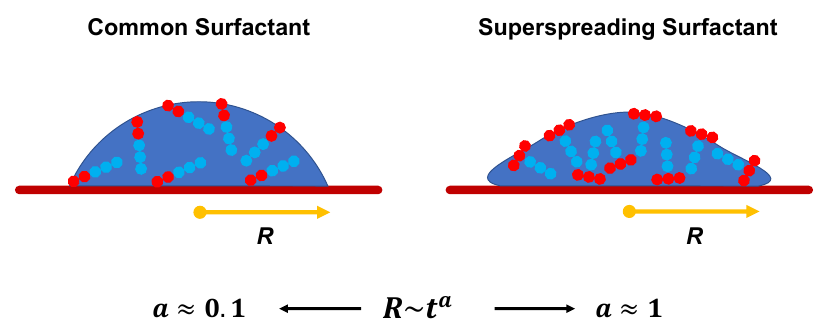
Figure 1. Schematics of aqueous droplets on a solid substrate at an intermediate time during spreading. Superspreading surfactants cause the fast and complete spreading of droplets. The base radius of the droplet, R , changes with time t with a power law dependence described by the relation R ∼ t α , where α is the so-called spreading exponent. In the case of superspreading α can obtain values as high as